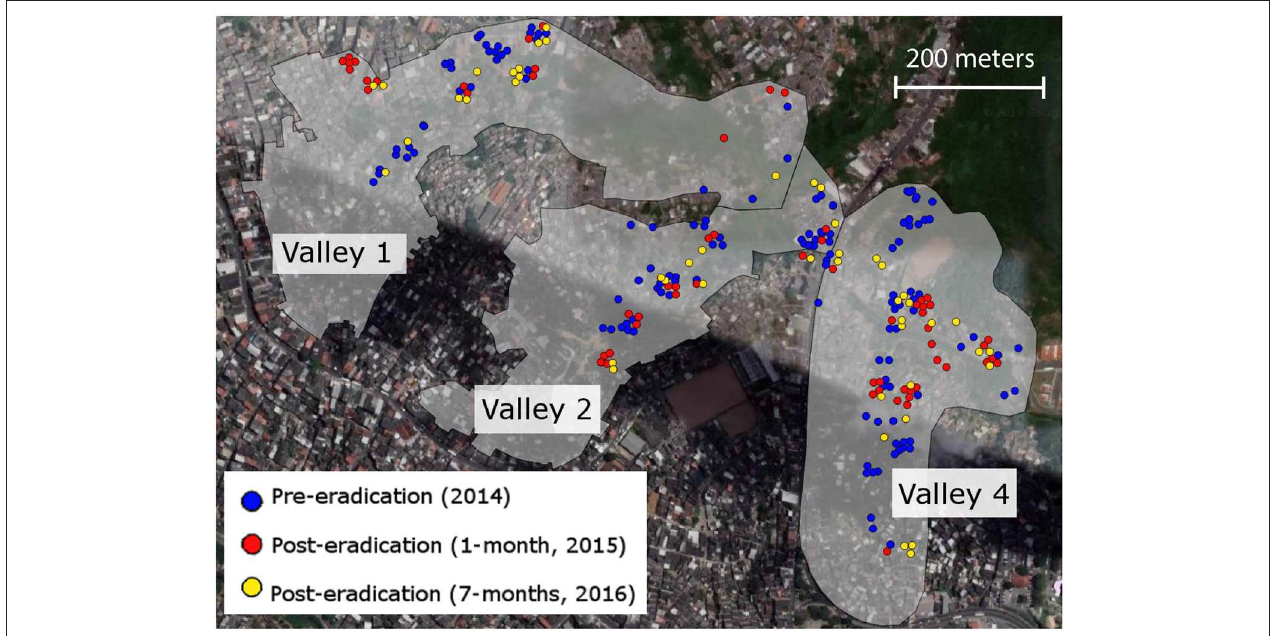
FIGURE 1 | The Pau da Lima section of Salvador, Brazil is comprised of four valleys, three of which were the target of an eradication campaign in mid-2015. We collected tissue samples from 241 rats trapped immediately before the campaign (blue points), and then 1-month (red points) and 7-months (gold points) after the campaign. These three valleys have been the focus of long-term epidemiological work to reduce human incidence of leptospirosis carried by Rattus norvegicus